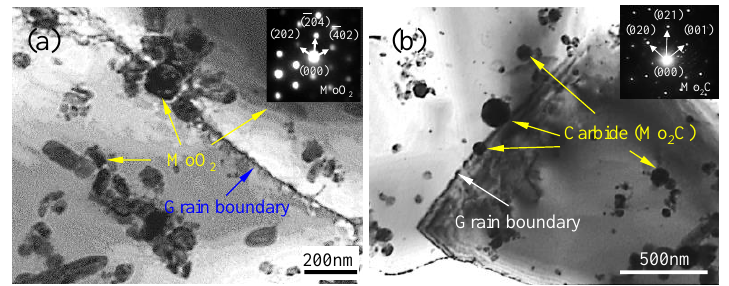
Figure 10. TEM images of ( a ) molybdenum oxide particles in the FZ of LW joint and ( b ) carbide particles in the FZ of SC-150 joint [9].